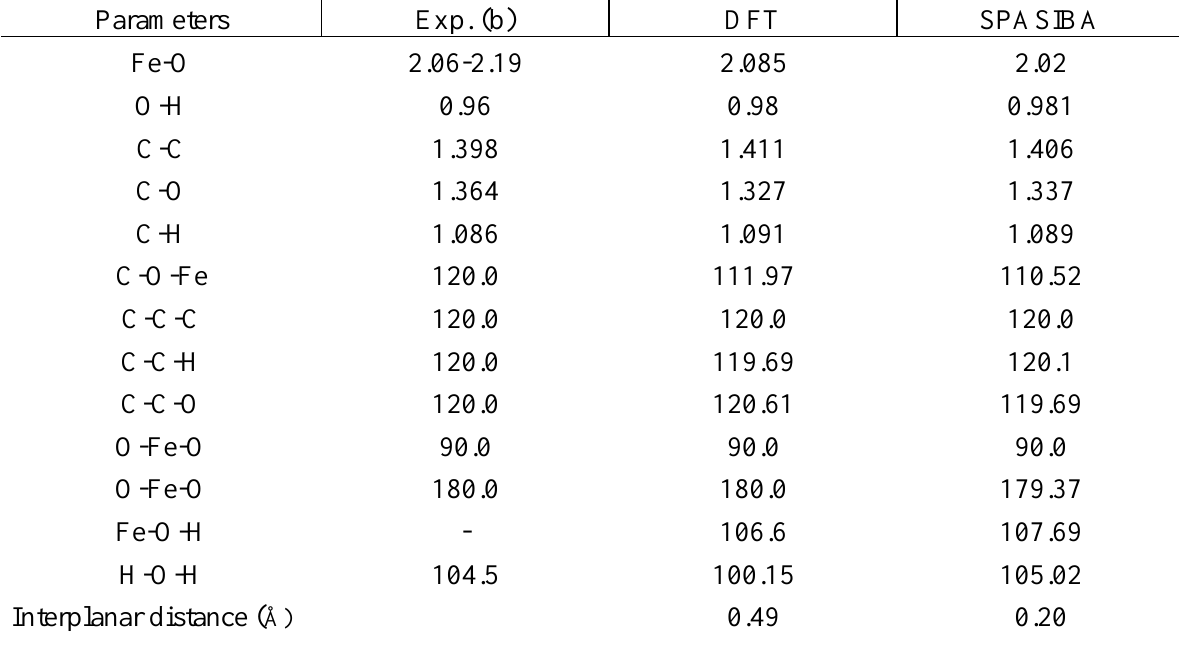
Table 5b . Mean structural parameters values obtained from DFT geometry optimization and